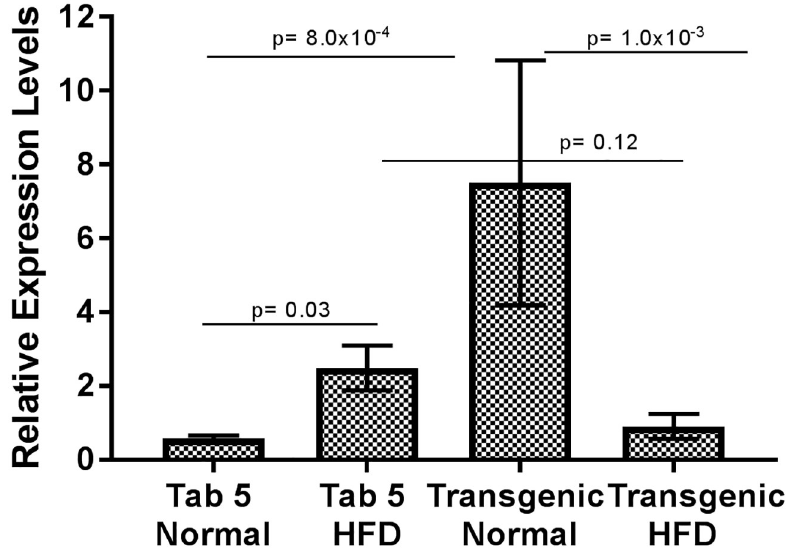
Fig 7. GCKR Relative Expression Levels. Graph summarizes the relative mRNA expression levels of GCKR normalized by beta actin in zebrafish larvae of wildtype (WT) Tab-5 and transgenic mutant fish fed on a normal and high fat diet (HFD). Data are presented as mean and standard error of mean using Tab-5 WT as reference. Significant differences in the relative expression of GCKR mRNA were detected between Tab-5 (WT) and the transgenic mutant on a normal diet; and between transgenic mutants on a normal diet vs.